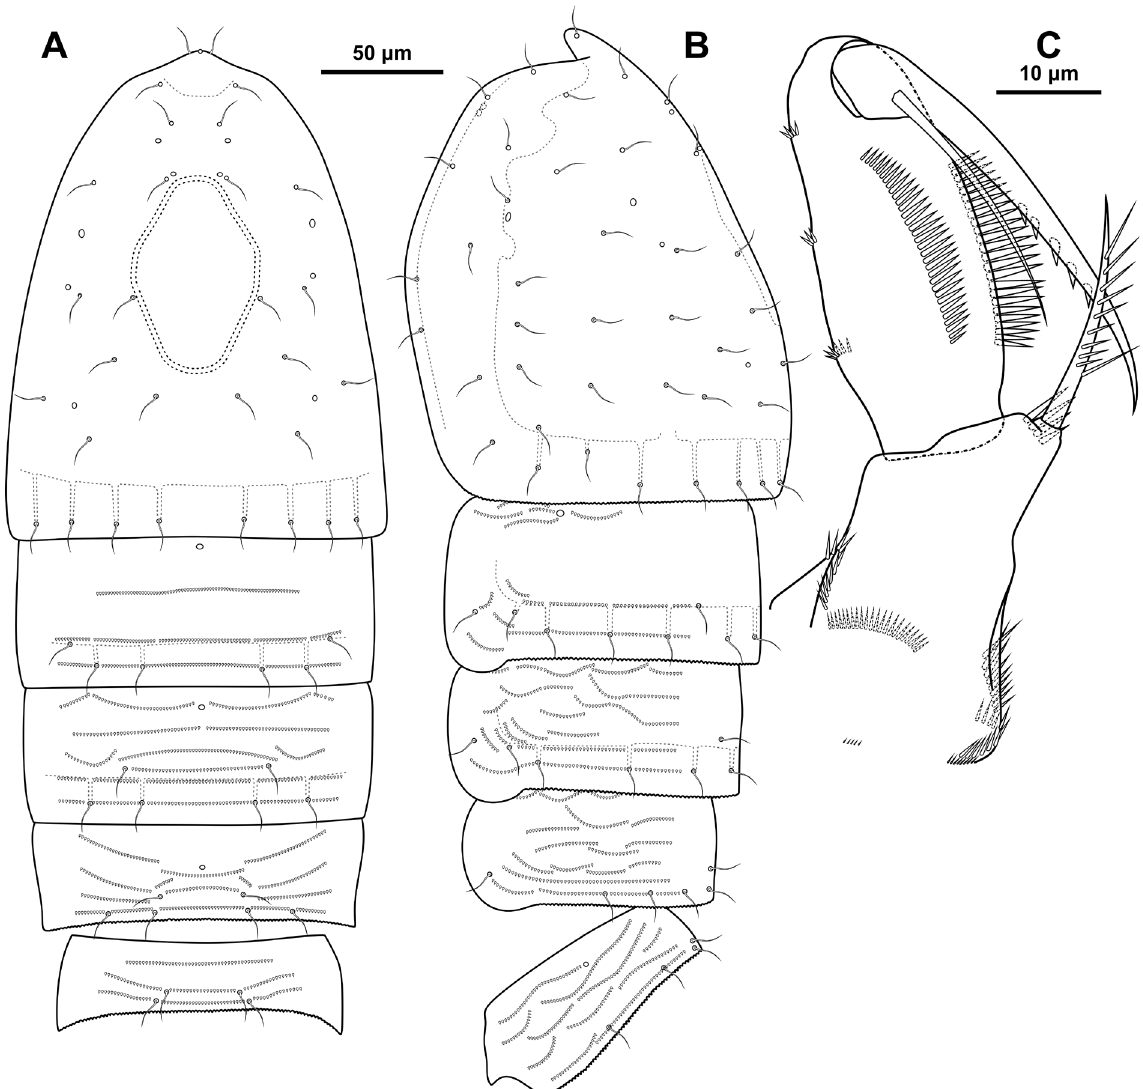
Fig. 2. Canthocamptus waldemarschneideri sp. nov., holotype, ♀ (KFU BP 544/1). A . Cephalothorax and thoracic somites, dorsal view. B . Cephalothorax and thoracic somites, lateral view. C .